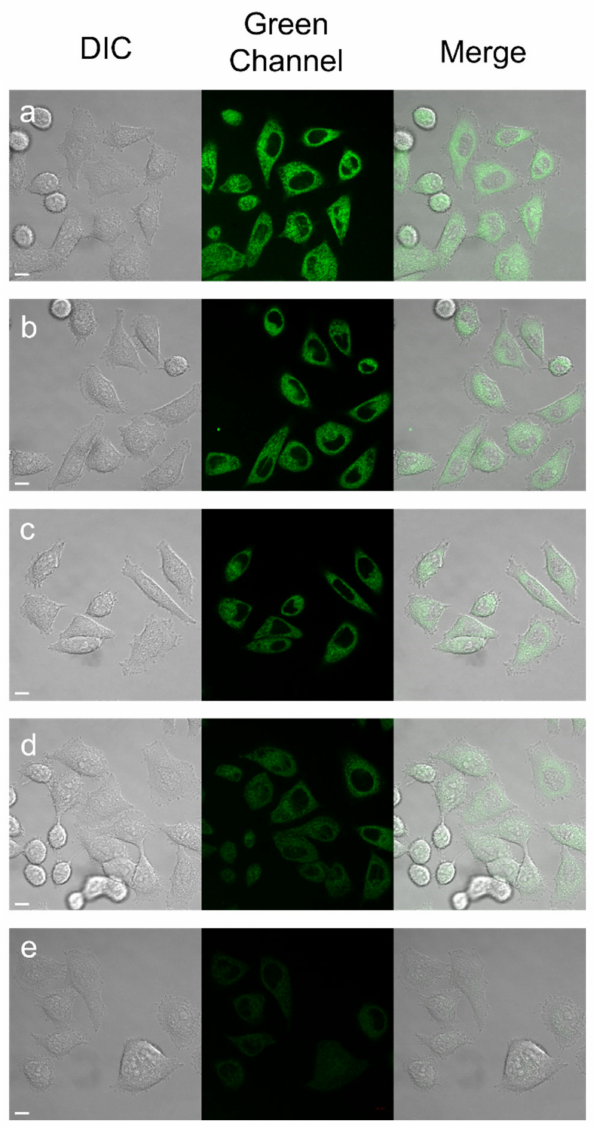
Figure 4. Confocal fluorescent images of HeLa cells after incubating with PFO-DPC and continuous exposure of exogenous Cr (VI) ion source treatment (0.00 nM ( a ), 0.38 nM ( b ), 0.77 nM ( c ), 1.15 nM ( d ) and 1.54 nM ( e )). Scare bar = 10 µ